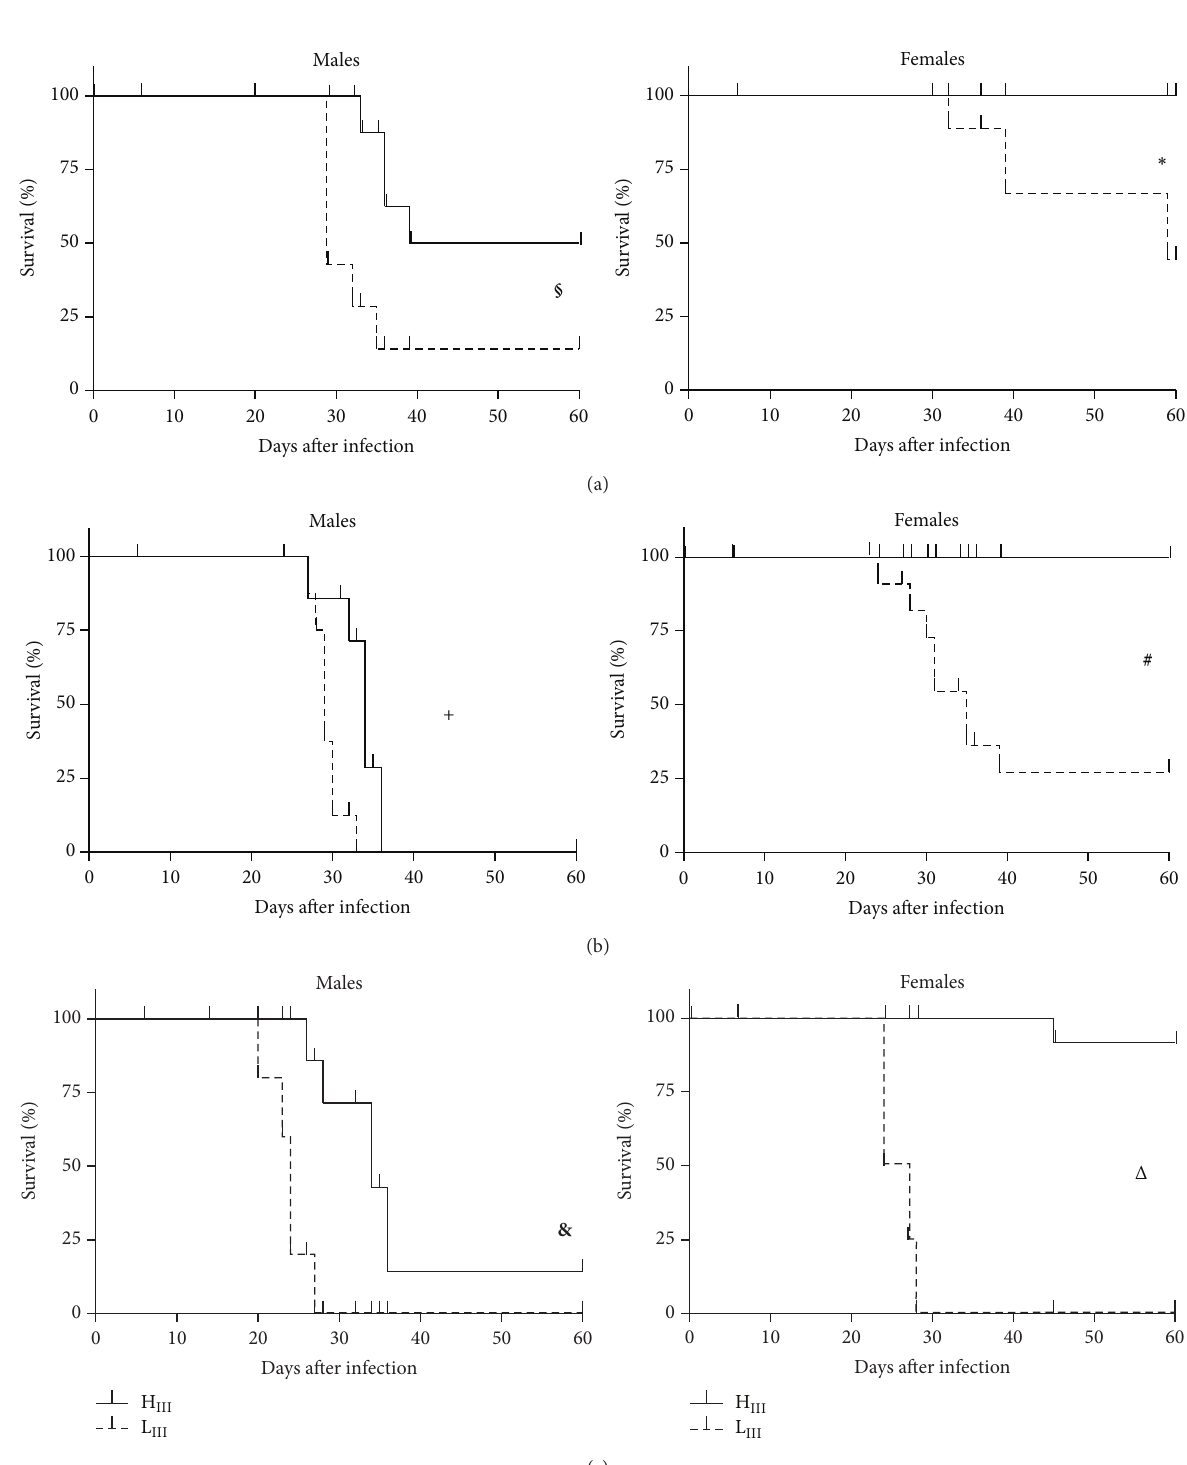
Figure 2: Survival curves of Selection III mice after T. cruzi infection. H III and L III mice (outbred stock) were infected (s.c.) with 10 (a), 10 2